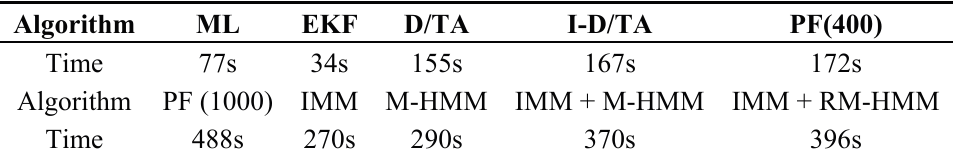
Table B1. Computing time of different